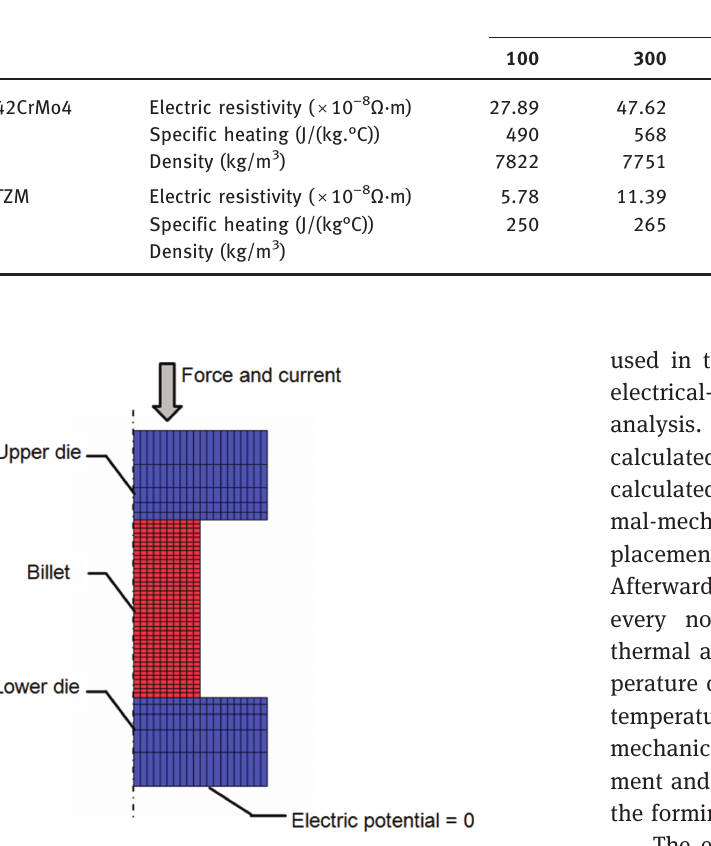
Figure 9: Finite element model of the experimental setup.